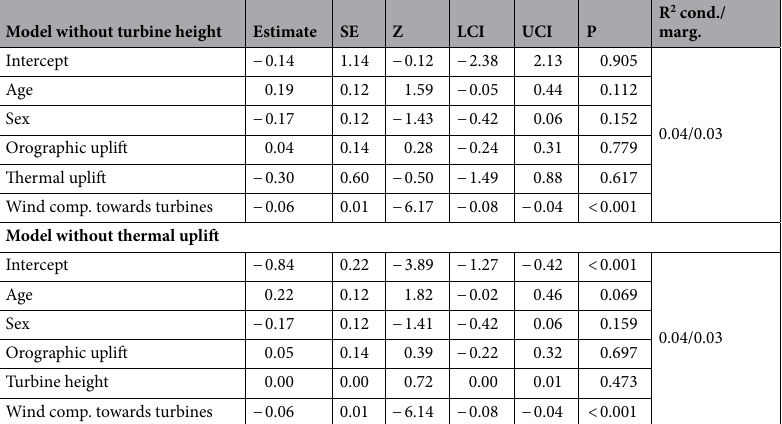
Table 2. Summary statistics of binomial Generalized Linear Mixed Models (GLMMs) relating the probability of birds to be oriented towards wind turbines to individual traits and environmental variables. Because thermal uplift and turbine height were highly correlated (Pearson’s correlation = 0.77) but were both important for the aims of this study, we included each of these variables as predictors in two alternative models. The modelling dataset is restricted to the proximity of turbines (up to 750 m) and low flight height (up to the maximum height of the turbines), where the strongest avoidance is expected (see Fig. 2a). The response variable was assigned to 1 if the bird’s flight heading deviated less than 60° from the bearing to the nearest turbine or 0 otherwise. Bird identity was included as a random effect in both models. Orographic and thermal uplift were estimated only for the turbine locations and did not account with potential airflow disturbance caused by the turbine functioning. Marginal and conditional R 2 were calculated with the function r.squaredGLMM from the MuMIn R-package 25 . SE standard error, Z test statistic, LCI Lower 95% confidence interval, UCI Upper 95% confidence